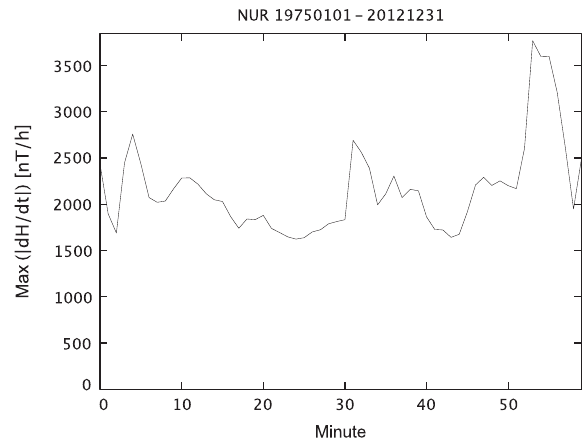
Fig. 4. Maximum hourly |d H /d t | at NUR in 1975–2012 for 1-h times series corresponding to spot readings at minutes 00, 01, ... , 59 (horizontal axis). Table 2. Top 20 days according to the maximum 1-min value of |d H /d t | at NUR in 1975–2012.